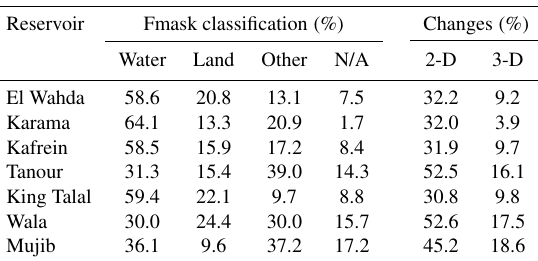
Table 3. Initial Fmask classification inside the final water areas (“Other” refers to clouds, cloud shadows, and snow), and stages’ percentage changes that led to the classification as water (“2-D” for the 2-D classification enhancement, and “3-D” for the 3-D recon- struction). “N/A” means not